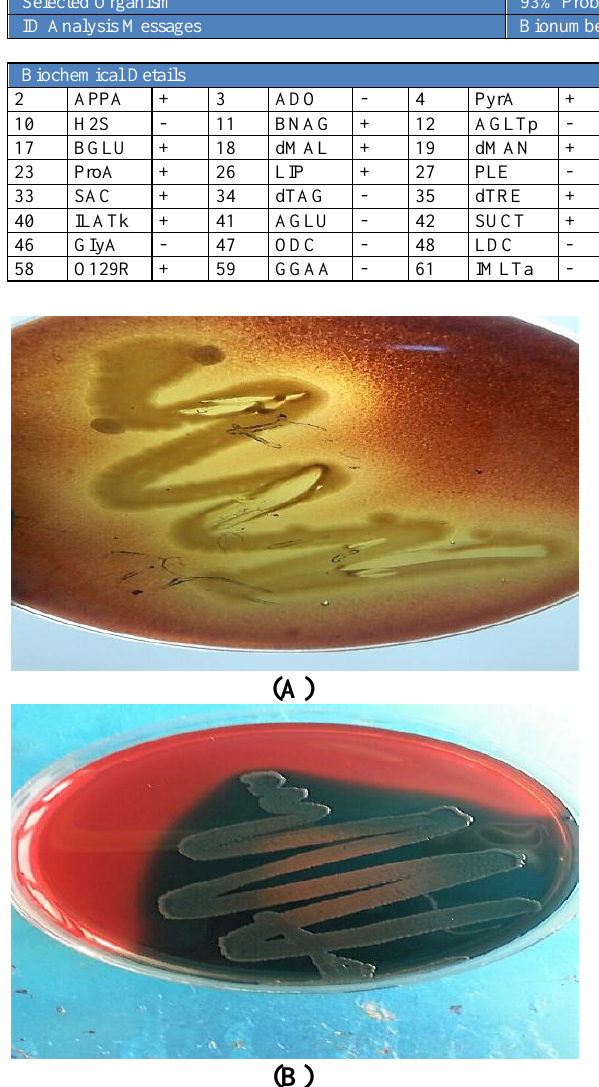
Figure, 1: (A) β-haemolysis by Aeromonas spp. (B) - Biofilm production by Aeromonas Spp.